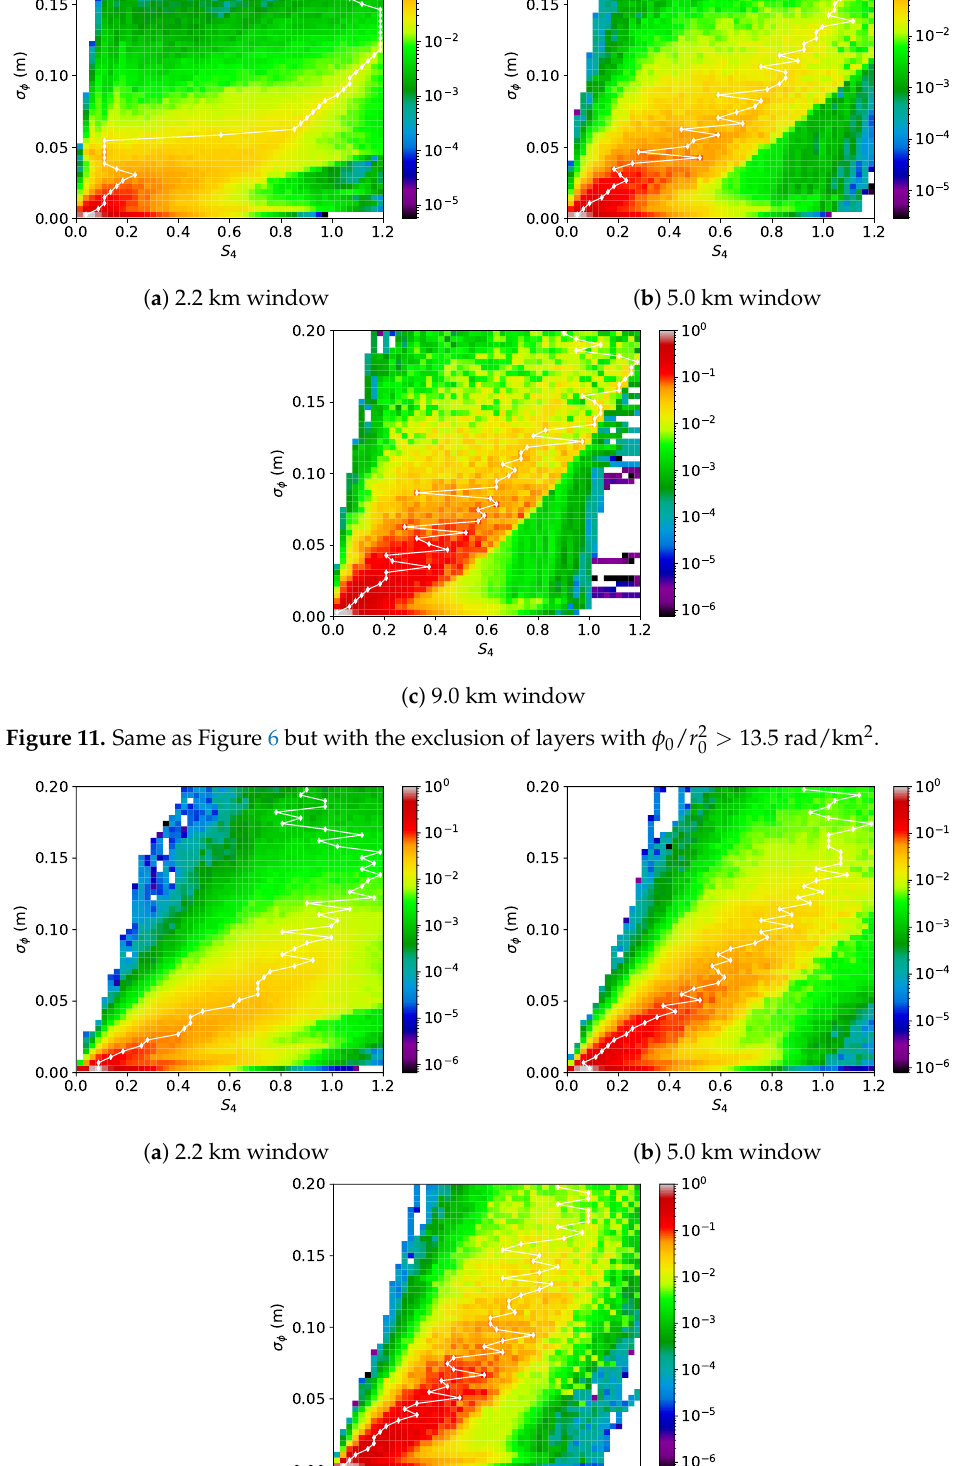
> 13.5 rad/km 2 0